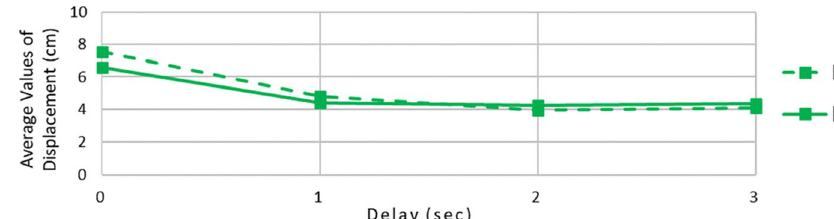
Fig. 13 Average tower top displacement